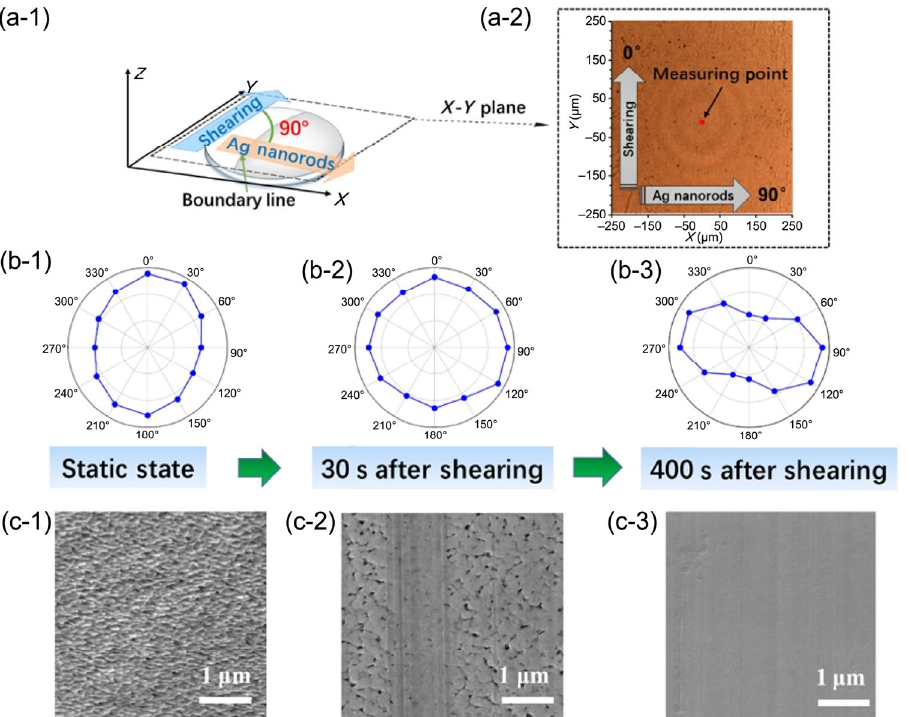
Fig. 3 (a-1) Schematics of a K9 plano-convex lens substrate covered with a Ag nanorod film under shearing, the X-Y plane was parallel to the surface, in-plane shearing was along the Y -axis, and the direction of the Ag nanorods was along the X -axis, here, the Y -axis was defined as 0°; (a-2) microscopic image of the contact area under shearing (rotating speed: 100 mm/s) at the initial state; (b) relative Raman intensity at different θ values (measuring point was marked as a red point in Fig. 3(a-2)), relative intensity of 1,600 cm − 1 in the corresponding Raman spectra expressed via a radar graph at the initial state (Fig. 3(b-1)), after shearing for 30 s (Fig. 3(b-2)) and after shearing for 400 s (Fig. 3(b-3)); (c) SEM images of the Ag film around the measuring point before and after shearing: Fig. 3(c-1) initial static state, Fig. 3(c-2) after shearing for 30 s, and Fig. 3(c-3) after shearing for 400